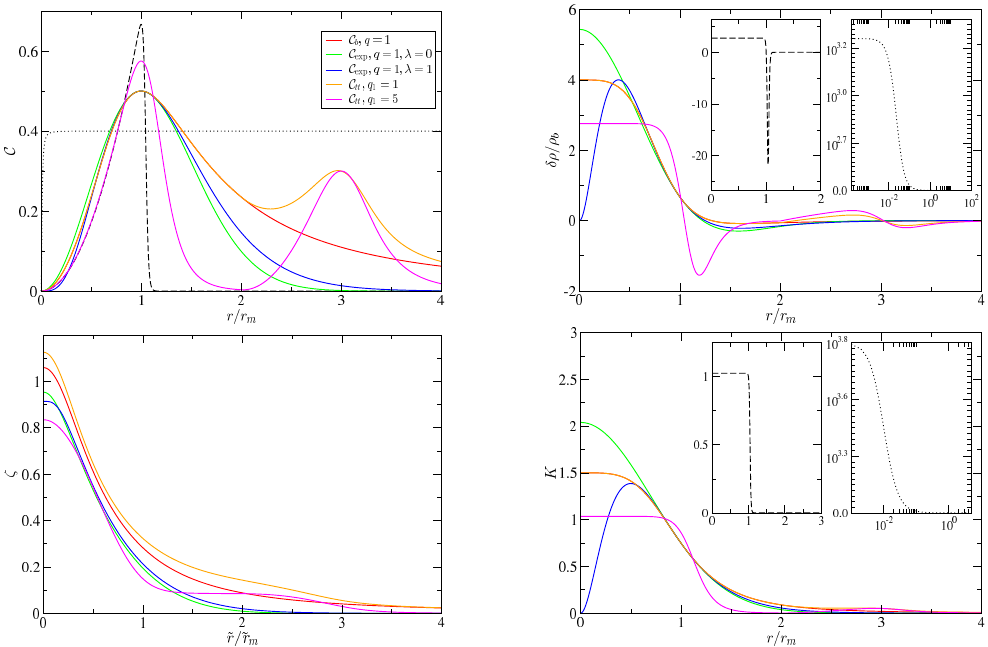
Figure 6. Plots for the profiles with Equations (82), (83), and (86) for C ( r ) ( top-left ), δρ ( r ) / ρ b ( top-right ), ζ ( r ) ( bottom-left ), and K ( bottom-right ) as a function of r / r m for δ m ∼ δ c . The dot- ted black line corresponds to q = 0 and the dashed black line to q → ∞ . The values taken for C tt ( r ) are δ 1 = δ c ( q 1 ) , q 2 = 3, r m 1 = r m 2 = 1, r j = 2 r m 1 , C tt ( peak,2 ) = 0.3, with the corresponding δ 2 obtained from Equation (88) using the previous parameters, q 1 = 5 (violet) and q 1 = 1